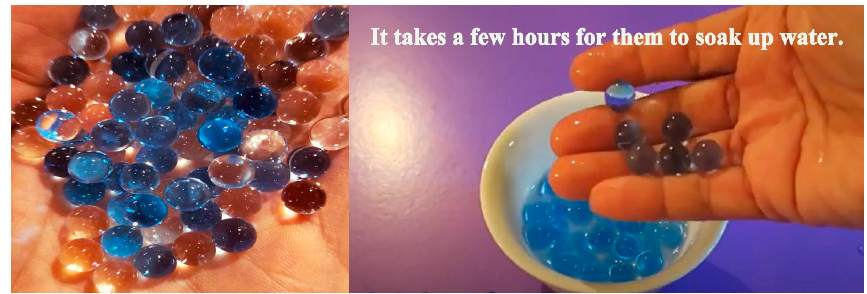
Figure 9. Environmentally friendly gel balls [17].